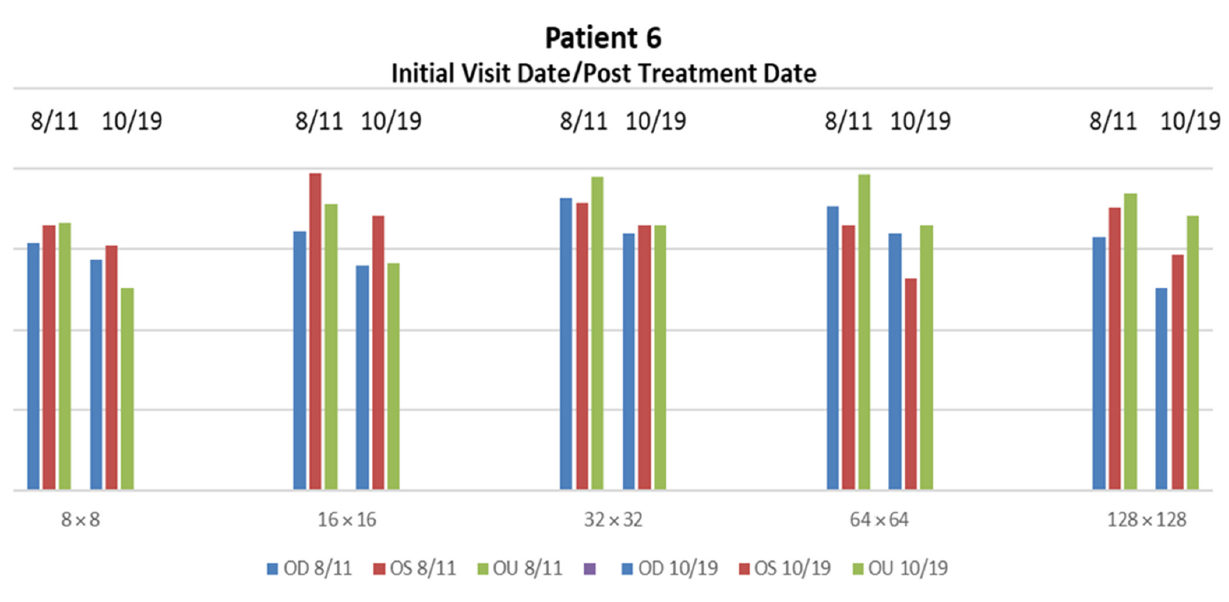
PSD values for these specific areas within the 2–3 range have shown to contribute to the measurement urement of improvement of visual issues from mTBI.